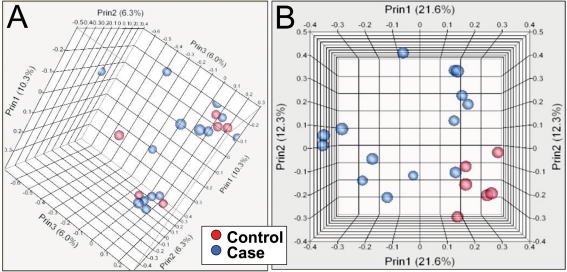
Unsupervised principal component analysis of log10 transformed array hybridization signals (A) and log10 transformed read frequencies (B).Three dimensional plots of principal component analysis by Pearson product-moment correlation. 14 SCZ samples are indicated by blue circles, and 6 control samples by red circles.